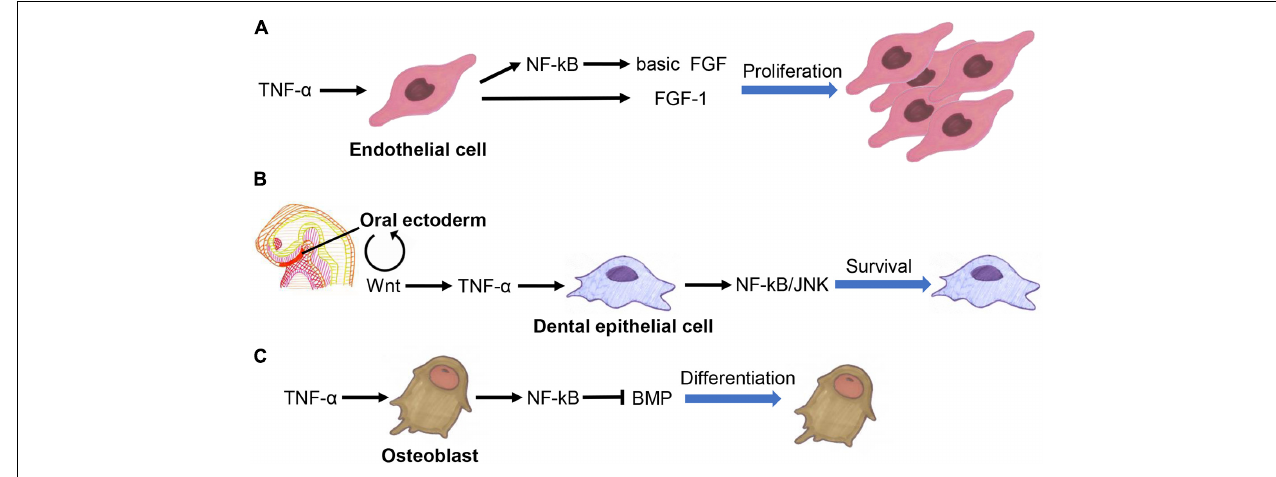
FIGURE 3 | Crosstalk between TNF- α fibroblast growth factor (FGF) family (A) , Wnt family (B) , and TGF- β superfamily members (C) in the regulation of